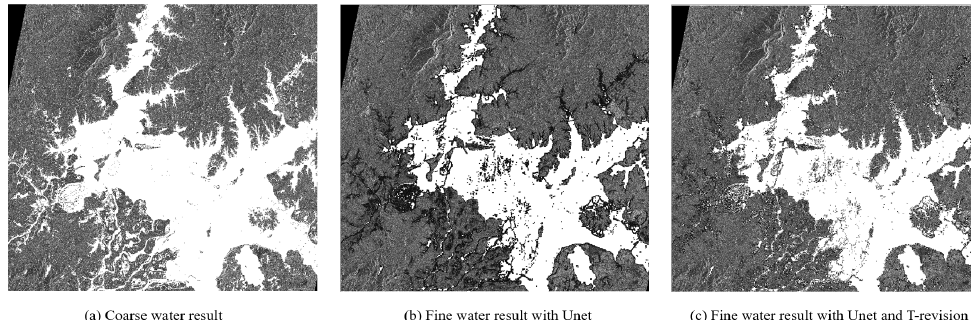
Figure 11. Fine water extraction of GF-3 SAR datasets.